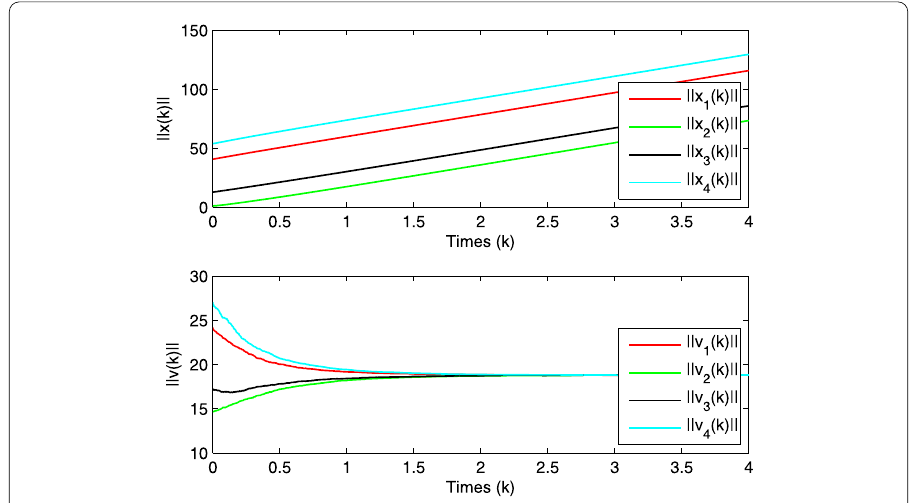
Figure 2 The norms of position and velocity trajectories with α = 0.5 in Case